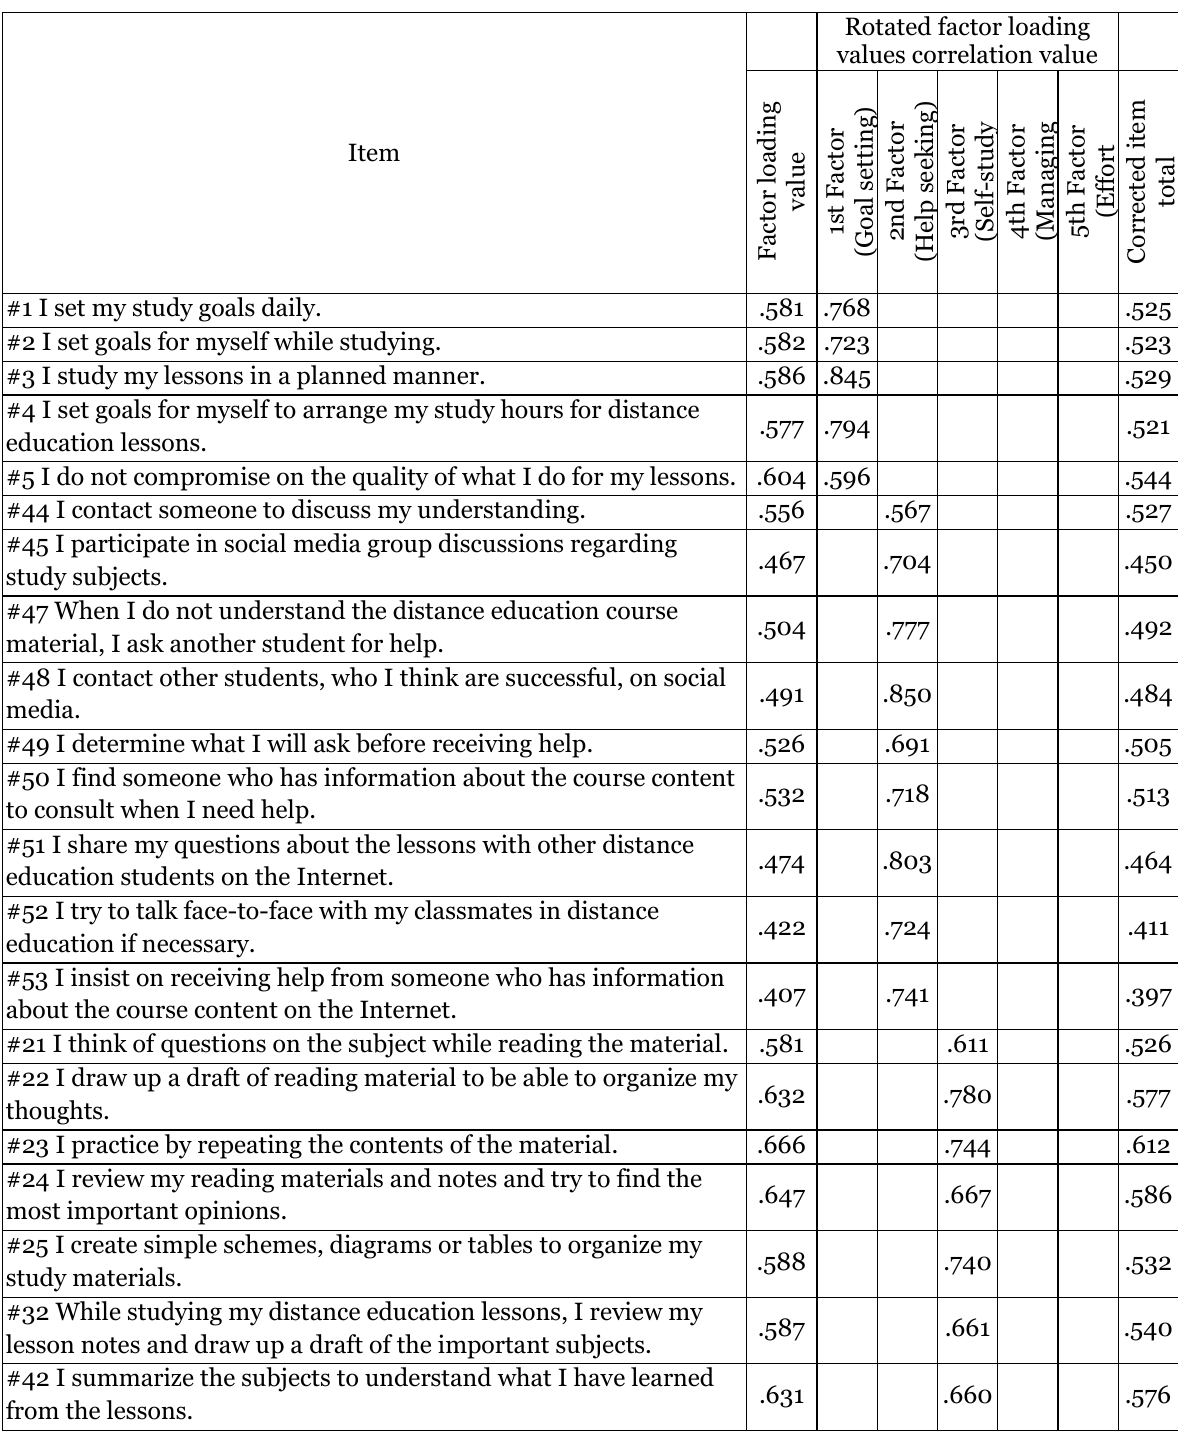
Table 5 Factor Loading and Item Total Correlation Values of the Items